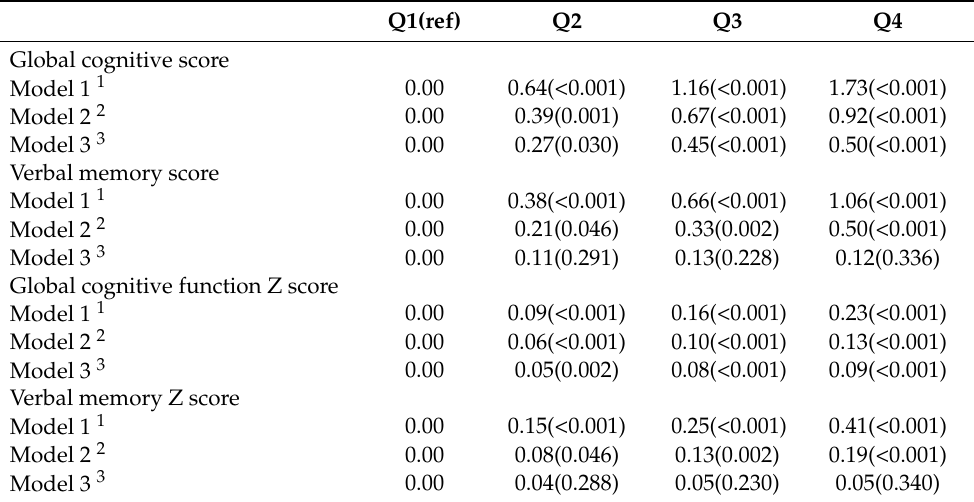
Table 3. Regression coefficients ( p value) for cognitive function by quartiles of “vegetable-pork” pattern score among Chinese adults aged ≥ 55 years old attending China Health and Nutrition Survey between 1997 and 2018. Q1(ref) Q2 Q3